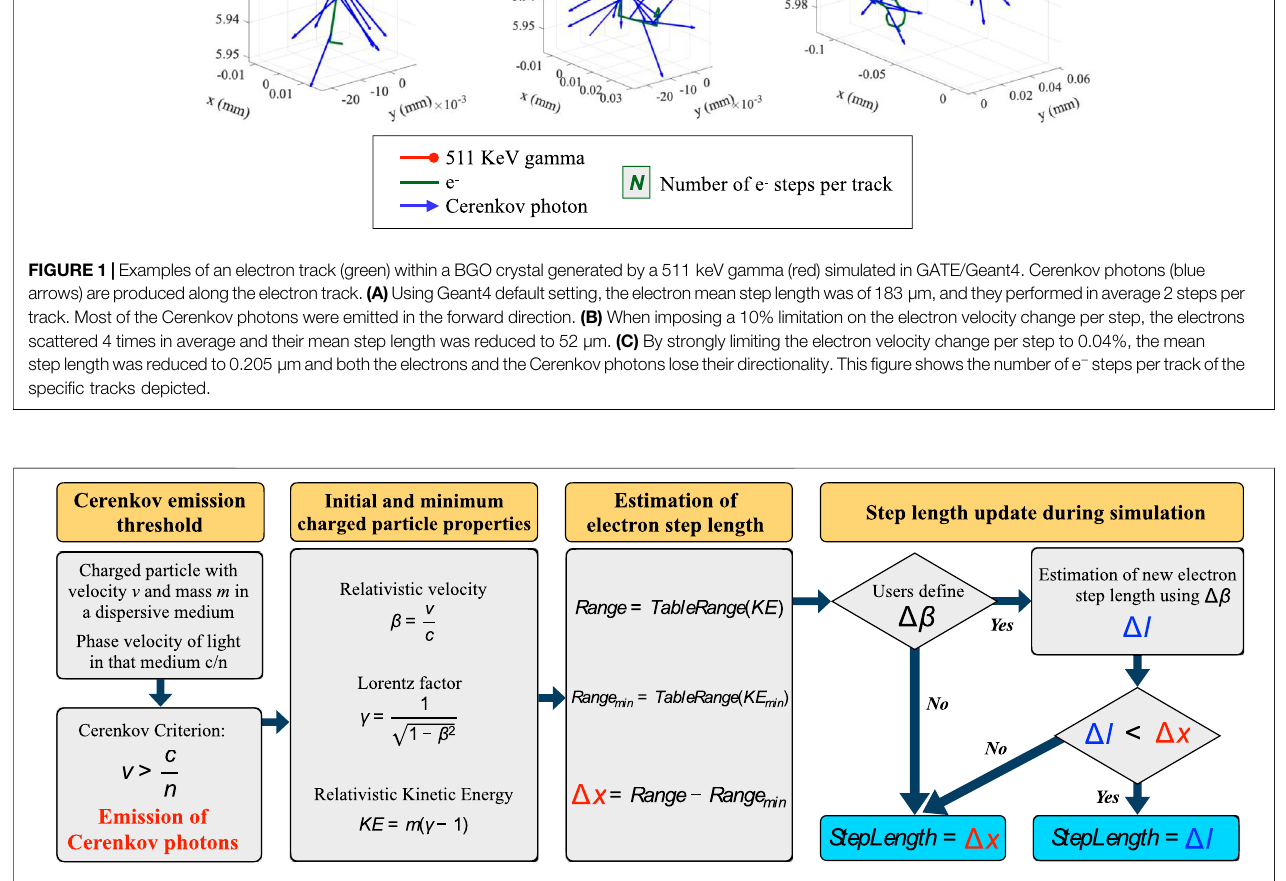
1 Evaluated data sets are produced through the process of critical comparison, selection, renormalization and averaging of the available experimental data, normally complemented by model calculations [23]